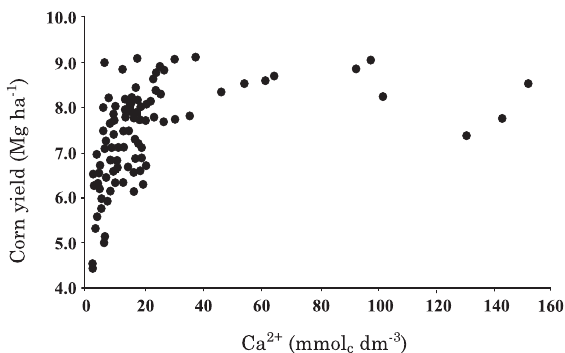
Figure 1. Scatter plot between corn yield and soil Ca 2+ content.